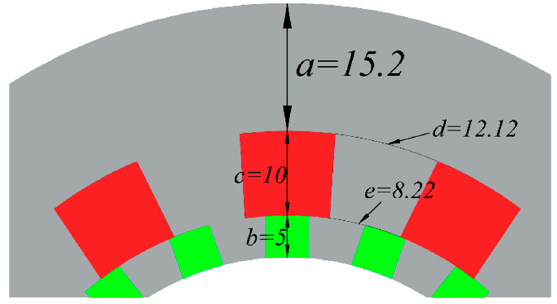
Figure 5. Original dimensions.